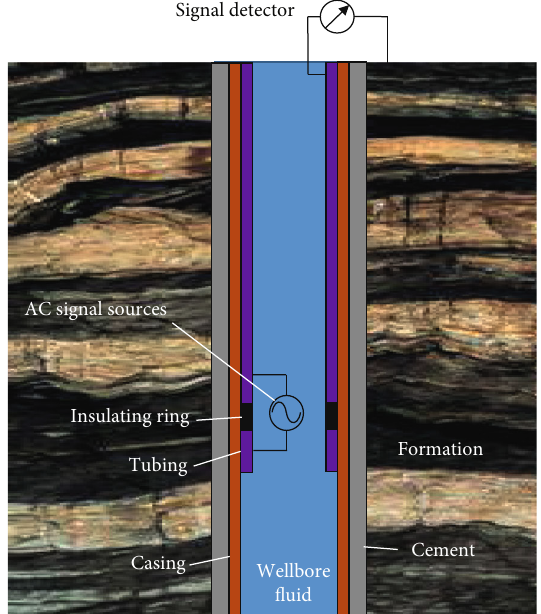
Figure 1: Principle of wireless monitoring of downhole pressure.